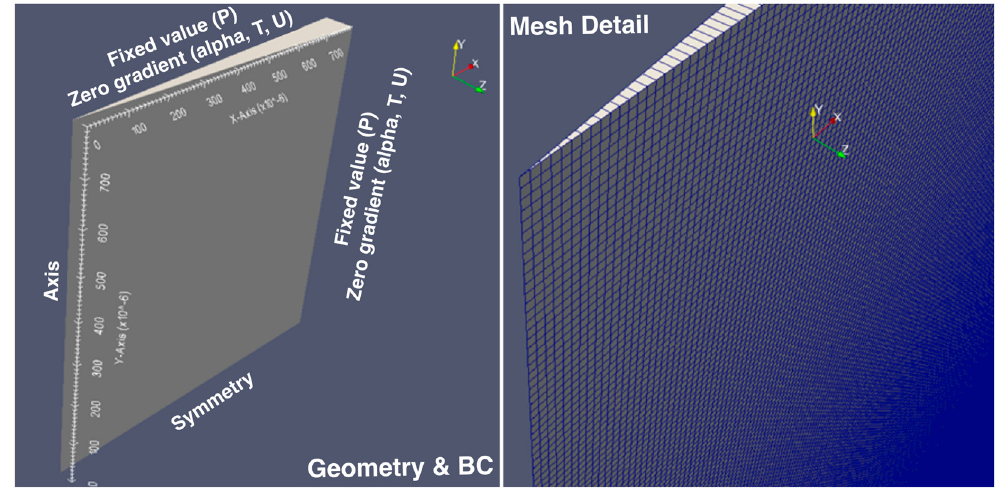
Figure 3. Two-dimensional axisymmetric computational domain, mesh and boundary conditions.